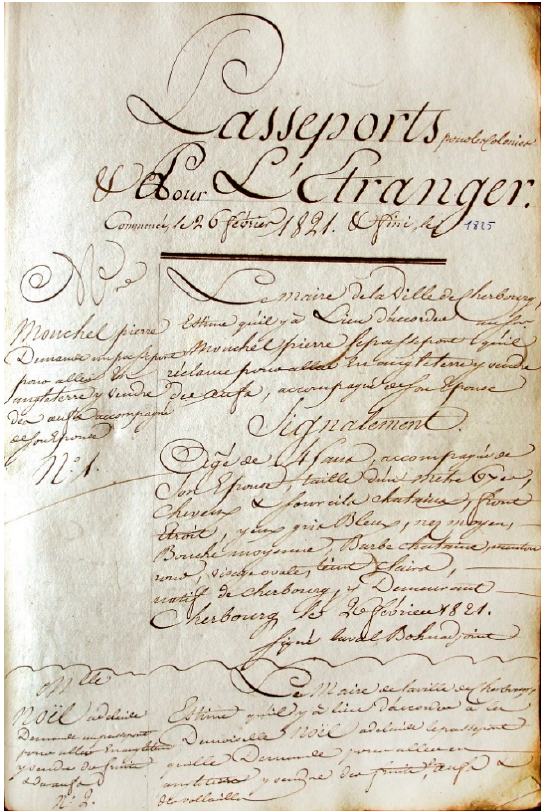
Figure 3. An index of this 1821 passport for Pierre Monchel exists in the IAP database.